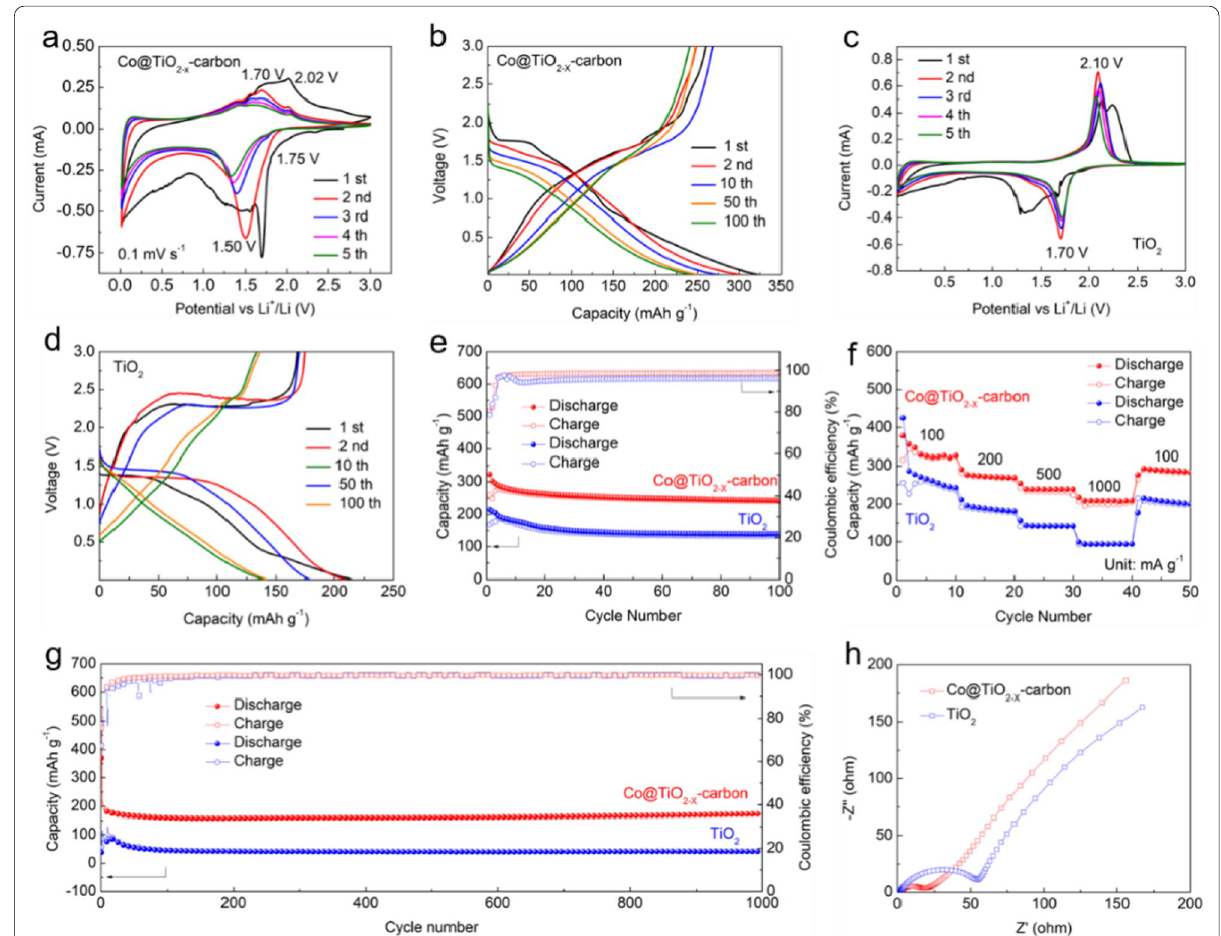
Fig. 6 CV curves of a Co@TiO 2 -carbon and c TiO 2 ; Charge–discharge voltage profiles of b Co@TiO 2 − x stability and f rate capabilities of as-synthesized products; g Long cycling performance of as-synthesized products at 1 A g − 1 ; h Nyquist plots of as-synthesized products before